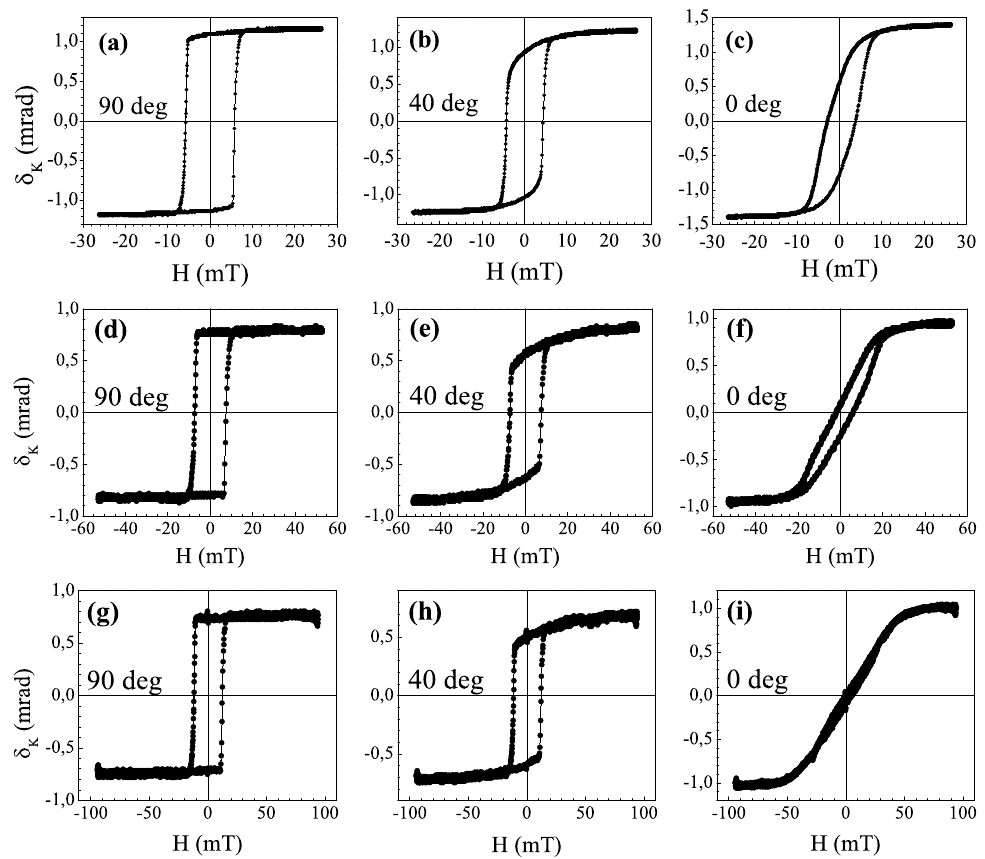
Figure 5. Dependence of Kerr rotation angle on the magnetic field and Φ angle for three locations on the Co nanocluster assembly: Panels ( a – c ) correspond to P6, panels ( d – f ) to P4, and panels ( g – i ) to P3, respectively. In all cases, Φ value is indicated in each panel.